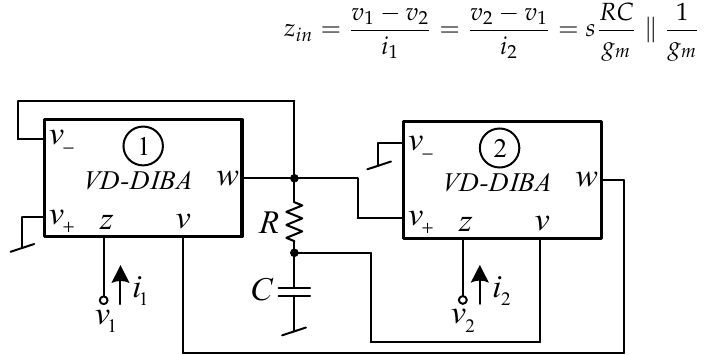
Figure 18. The floating parallel inductance-resistance simulator based on VD-DIBAs.